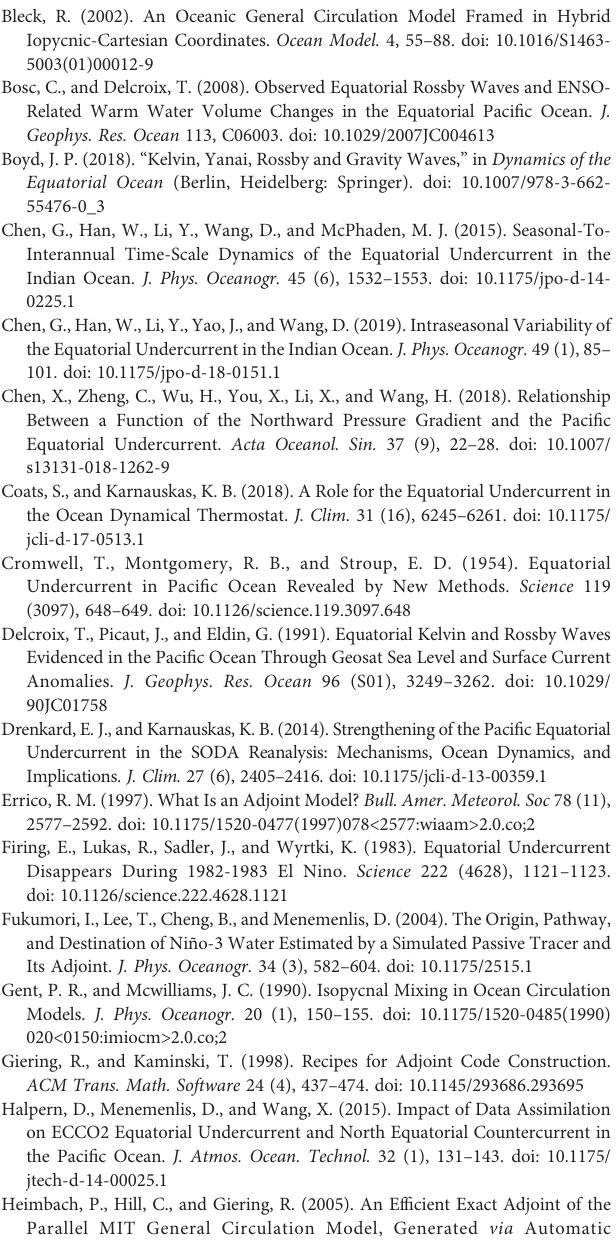
Supplementary Figure 1 | The difference between adjoint sensitivity and traditional forward perturbation sensitivity from Jones et al. (2018). Supplementary Figure 2 | Schematic diagram of the relationship between the adjoint model and nonlinear model.